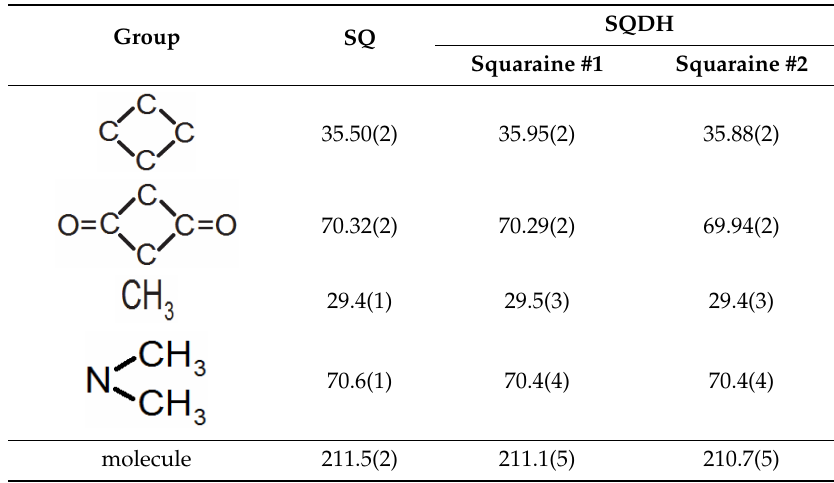
Table 7. Experimental Group Volumes (Å 3 ) of the squaraine molecules in SQ and SQDH crystals from QTAIM partitioning of the electron density. a Esds on the last significant digit are reported in